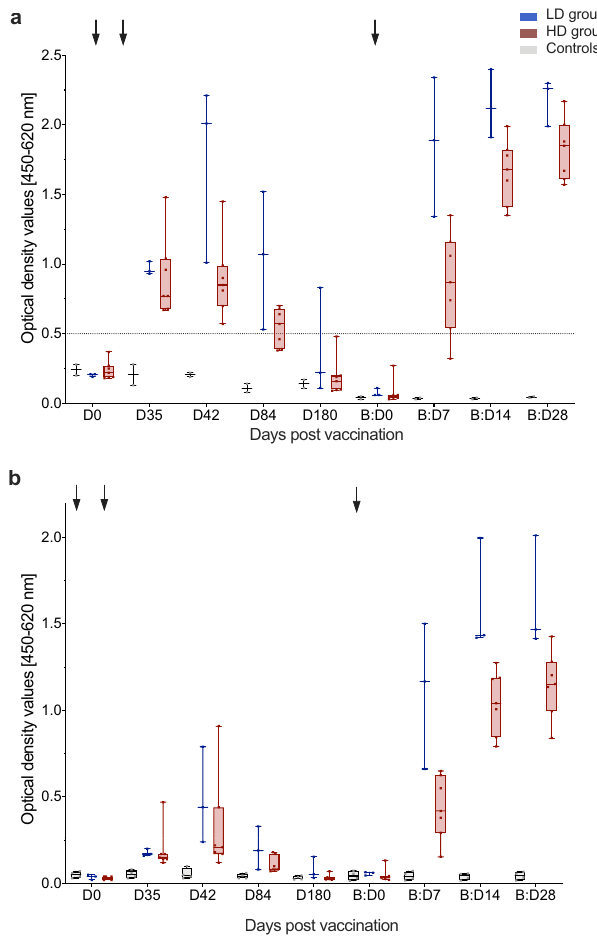
Fig. 3 Increase in anti-MERS-CoV-S-speci fi c binding antibodies after booster vaccination. Anti-MERS-CoV-S-speci fi c binding antibodies were measured as optical density values ( y -axes) by two distinct ELISAs a in- house ELISA, b EUROIMMUN ELISA) at multiple timepoints after fi rst (Day (D) 0 (D0), D35, D42, D84, D180) and booster (B) (B:D0, B:D7, B:D14, B:D28) vaccinations ( x -axes). Former low dose (LD, n = 3) and high dose (HD, n = 7) vaccinees are depicted in blue and red, respectively, controls in gray ( n = 2 in ( a ) and n = 4 in ( b )). Boxes indicate 25 – 75 percentile; whiskers are min. to max.; medians are shown as horizonal lines within the boxes. Arrows indicate vaccinations. The horizontal dashed line in ( a ) indicates the cut-off level for positivity. Source data are provided as a Source Data fi